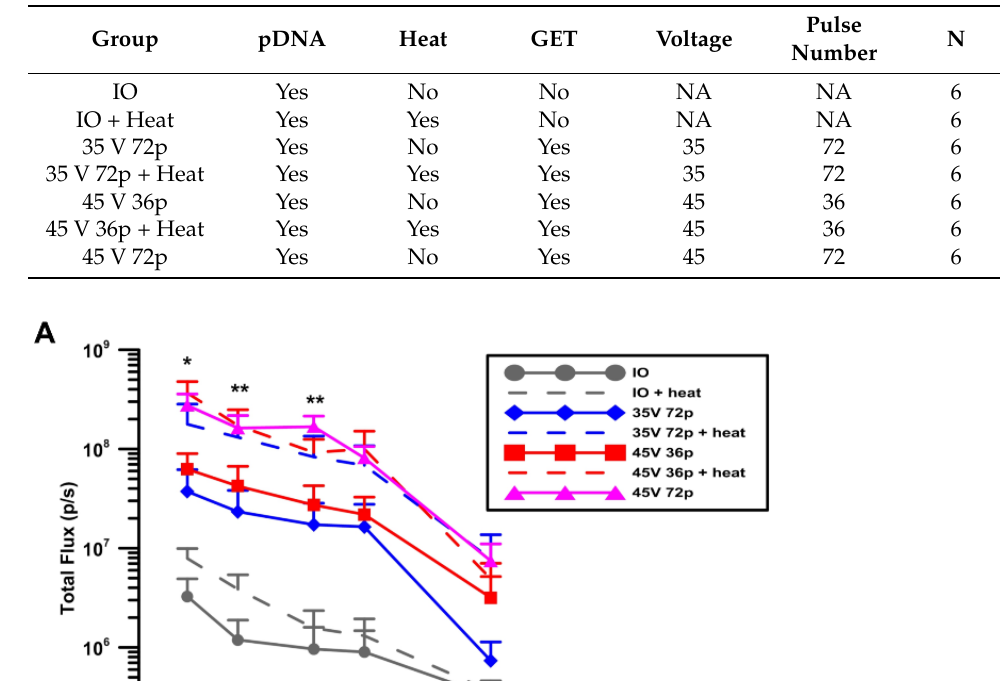
Table 1. Kinetics of moderate heat-assisted GET—pulse parameters.